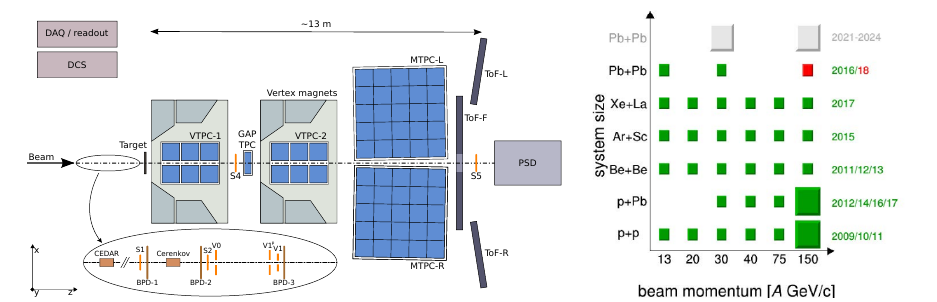
Figure 1. Left: NA61 / SHINE detector configuration. For details see text. Right: Data taking status of the strong interaction program of NA61 /